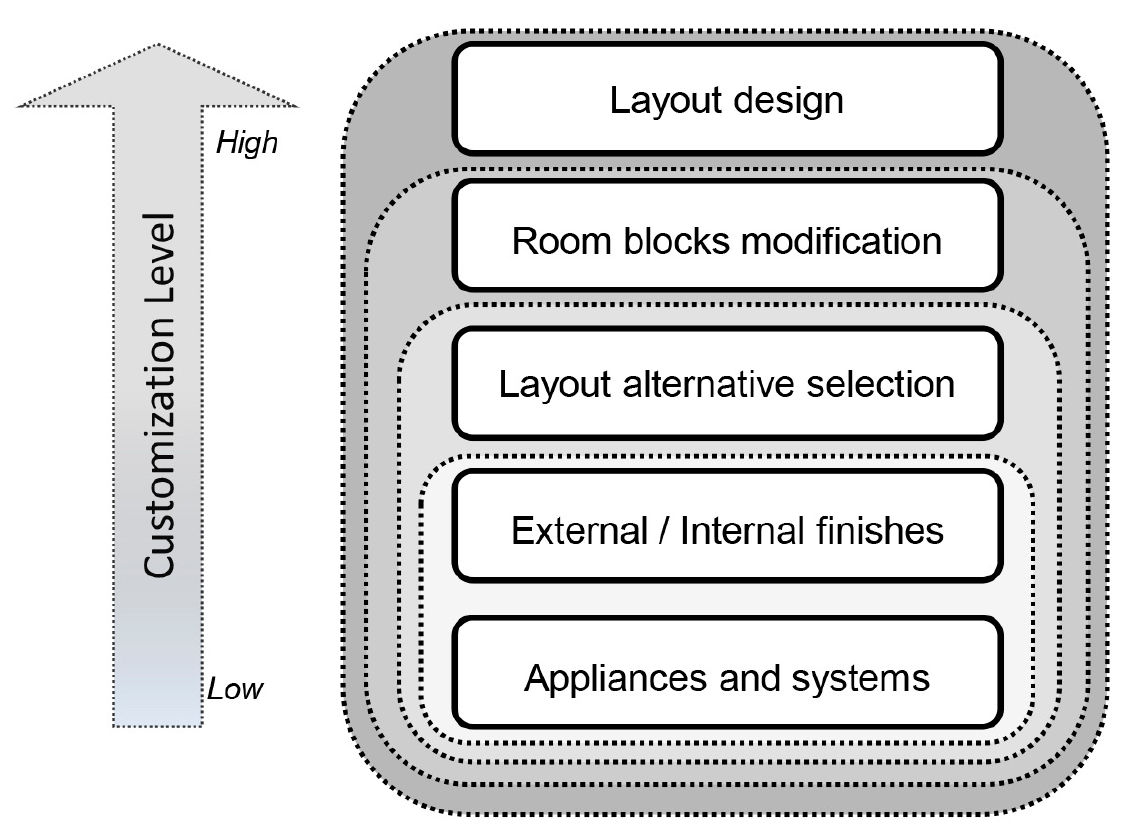
Figure 2. Levels of customization in housing organized sequentially from low to high, as a series of decisions offered to homebuyers.